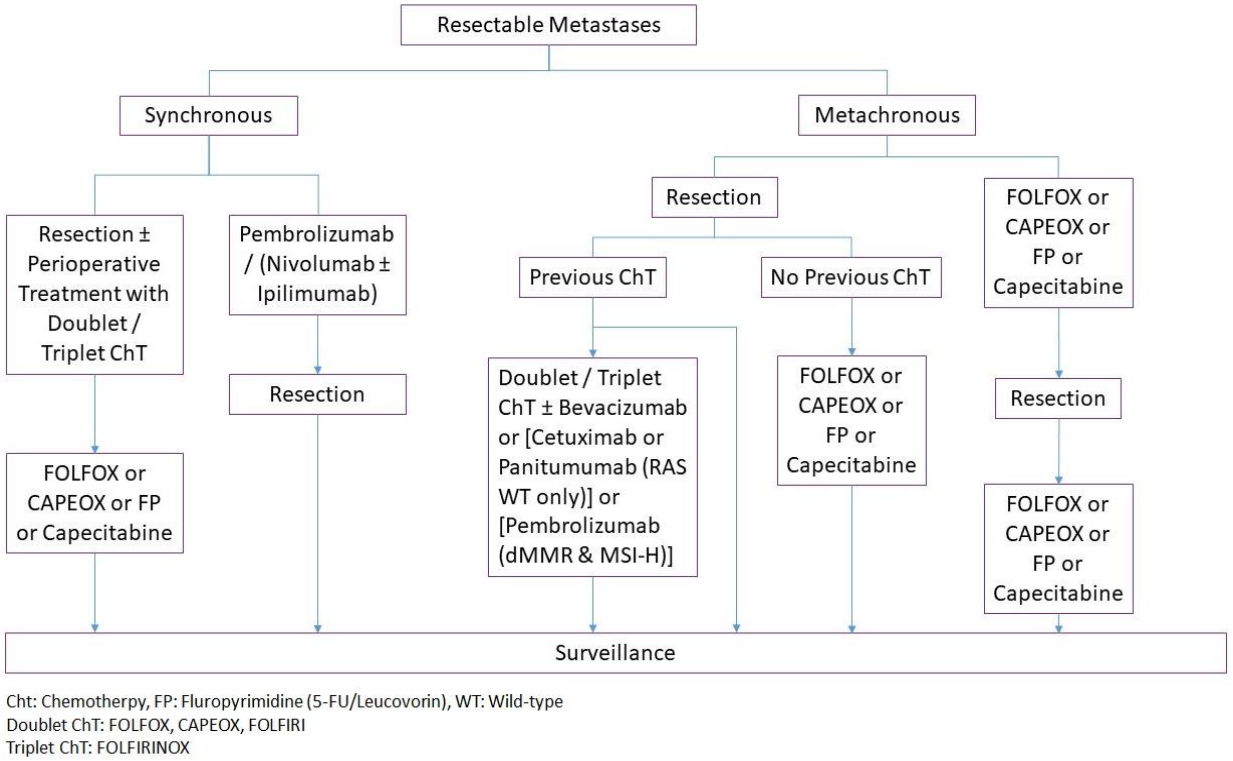
Figure 5. First-line Systemic Treatment for Stage IV CRC with Resectable Metastases. Regimens with a three-drug (triplet) combination, FOLFIRINOX or FOLFOXIRI, are also available as first-line therapy and are commonly paired with bevacizumab.